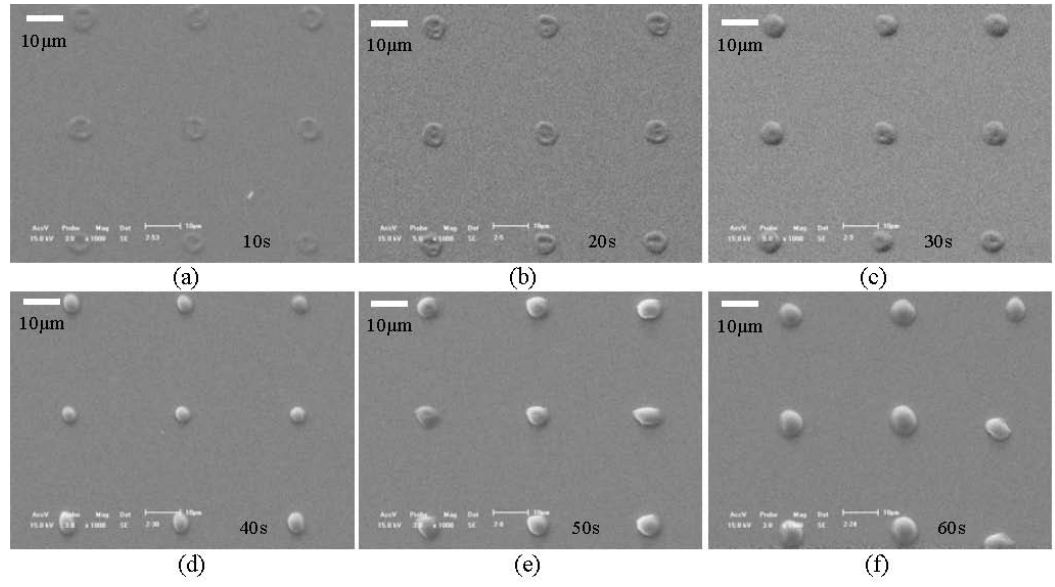
Figure 6. (a-f) show the SEM images of the polymer structures formed by a “spot” projected onto the “ODEP chip” with depositing time ranging from 10 s to 60 s, at an interval of 10 s. The images clearly show the evolutionary process of polymer structure formation—both the geometry and thickness of the polymer structures formed by the “ODEP System” depend on the projection time of a visible-light image onto the “ODEP chip”. The heights of the structures shown in Figure 6(a-f) were measured by an AFM and have the values of 233 nm, 455 nm, 687 nm, 950 nm, 1.34 µm and 1.62 µm, respectively (sequencing from (a) to